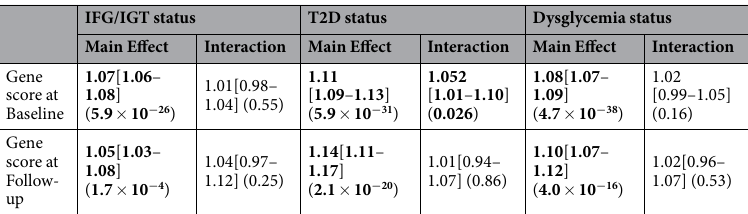
Table 3. Main effect and interaction of GS with depression status on T2D-related-traits at baseline and follow-up. Logistic regression models adjusted for sex, age, BMI and